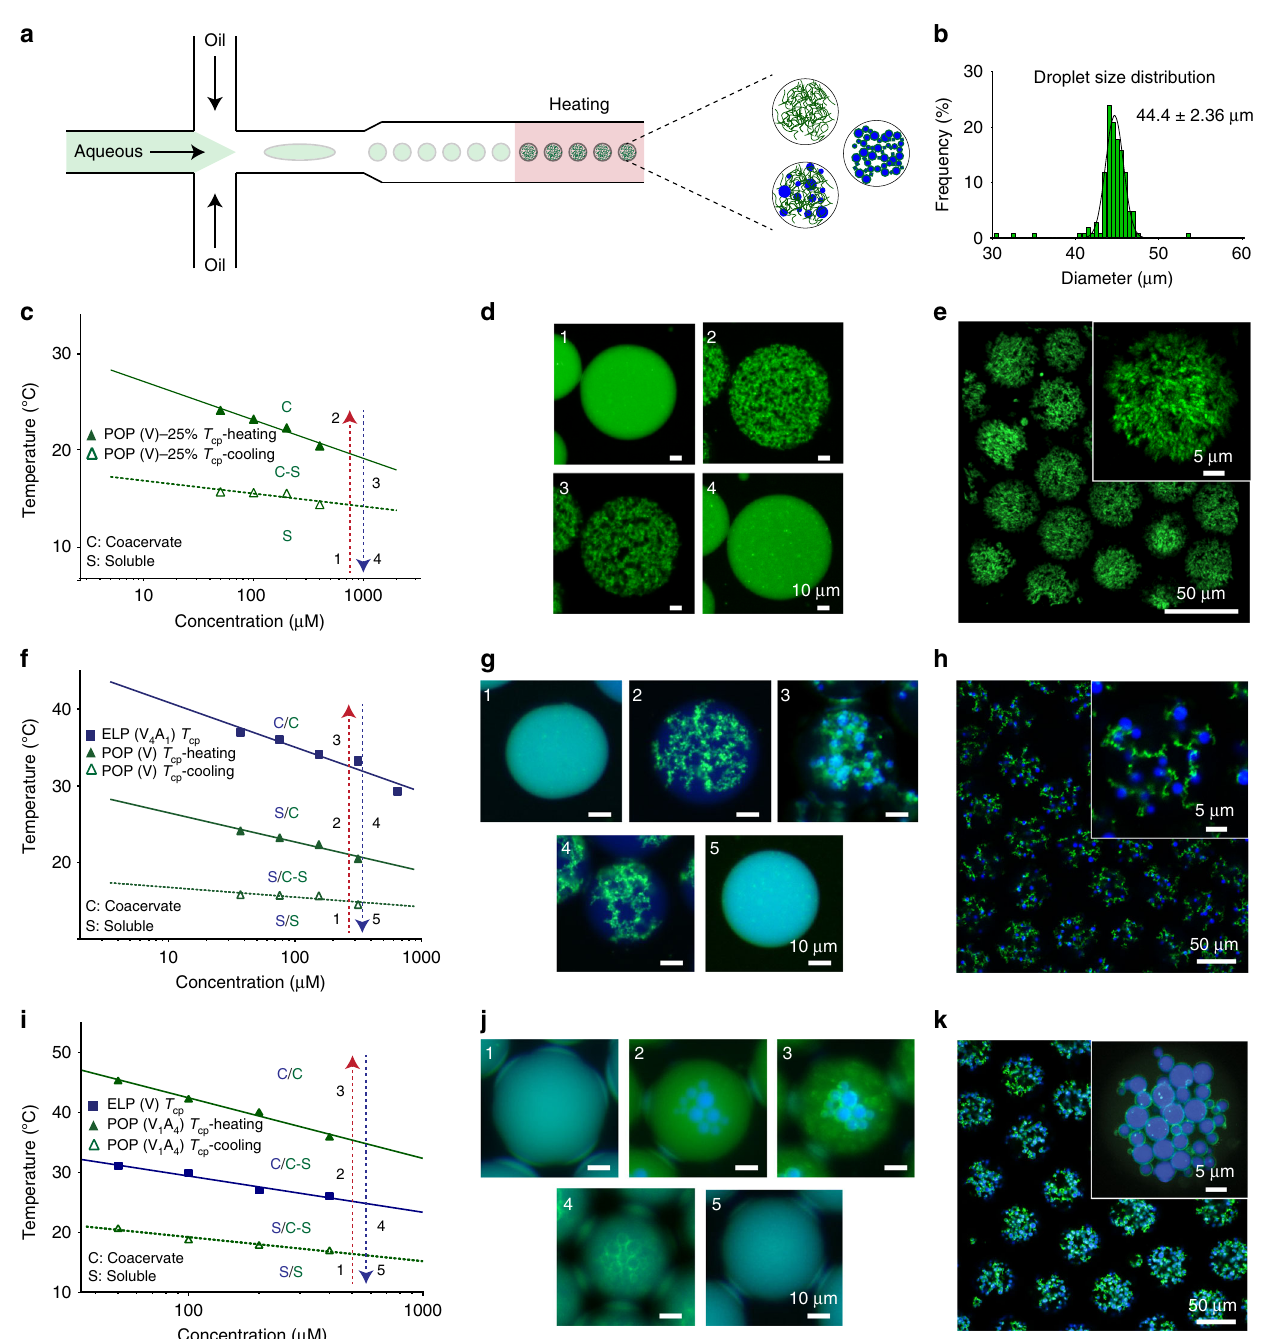
Fig. 2 Microdroplet architectures. a Depiction of the micro fl uidic device used to generate microparticles. b Image analysis of droplets ( n = 125 droplets) reveal a high degree of monodispersity. c Partial phase diagram for POP(V)-25% illustrating the different discrete states possible during a heating and cooling cycle. d Fluorescence images of POP(V)-25% (500 µ M) microdroplets during a heat-cool cycle through the states shown in ( c ). The metastable hysteretic range prevents dissolution of the particles until the solution temperature is lowered below the T cp -cooling. e Confocal images (25 µ m stack) of the same particles in the metastable hysteretic state — state 3. f Partial phase diagram for mixtures of POP(V)-25% (200 µ M) + ELP(V 4 A 1 ) (200 µ M) depicting the different discrete states possible during a heat-cool cycle of this system in which the POP aggregates at a temperature below the ELP. g Fluorescent images of each state of the cycle demonstrating the formation of the fruits-on-a-vine architecture in state 3. h Confocal images of state 3 clearly depicting the ELP “ fruits ” . i Partial phase diagram of ELP(V) (500 µ M) + POP(V 1 A 4 )-25% (100 µ M) depicting the states available during a heat-cool cycle. j Fluorescent images of each state of the cycle. Due to the hysteretic nature of the POP and its lower T cp -cooling than the T cp of the ELP, the ELP dissolves fi rst upon cooling, diffusing out and leaving a network of hollow POP shells. k Confocal images of core-shell networks formed in state 3. Source data are provided as a Source Data fi